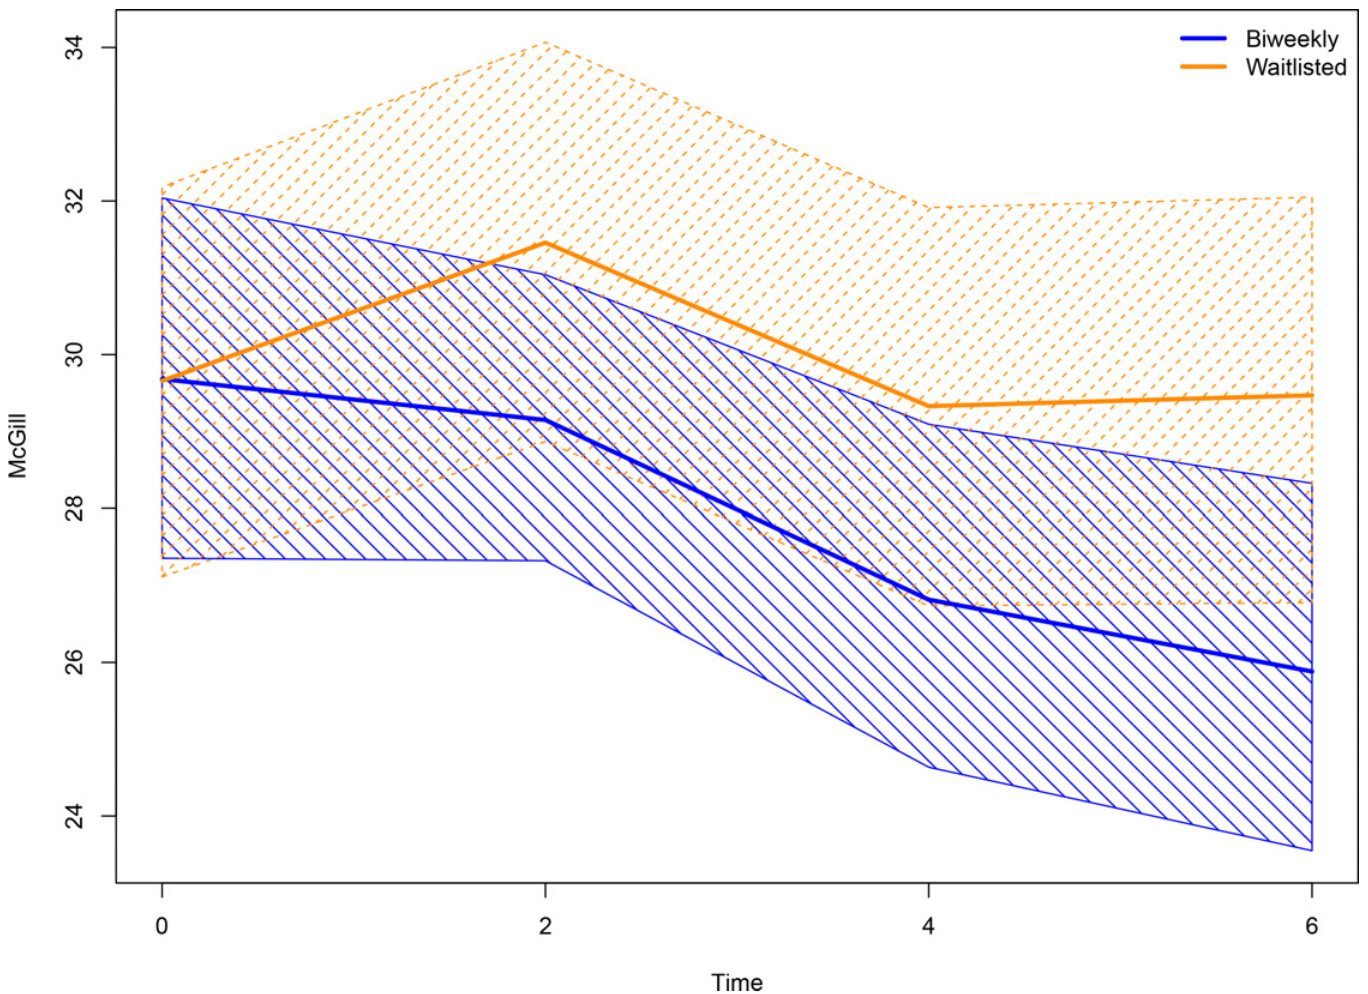
Fig 3. Summary of model-based simulations xxxiii of changes in mean McGill Pain Scale at 4 measurement timepoints. Scores moving in the negative direction indicate improvement. Scores moving in the negative direction indicate improvement.